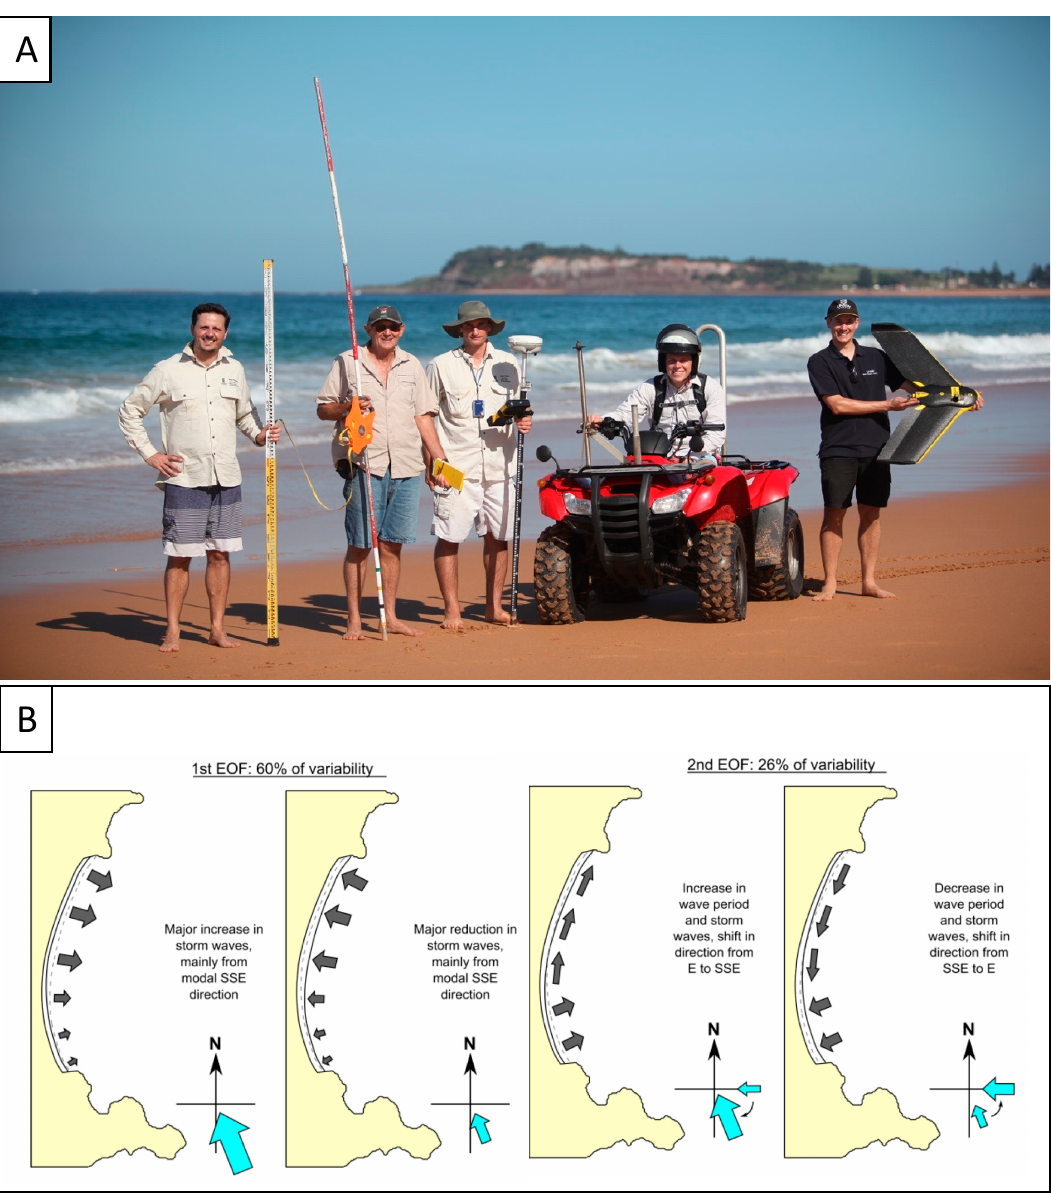
Figure 4. ( A ) Picture of survey methods with (l–r) Emery Method, RTK-GPS, all-terrain vehicle (ATV) RTK-GPS and Unmanned Aerial Vehicle (UAV) (photo credit: Larry Paice). ( B ) New insights into embayed beach rotations (Source: [13]).